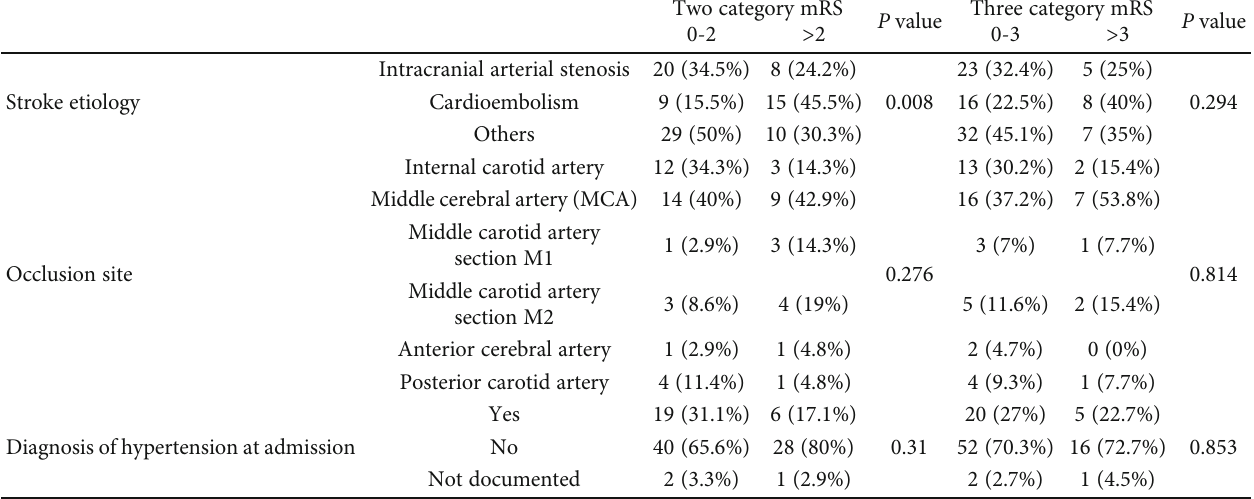
Table 3: E ff ects of diagnostic factors on mRS categories at discharge.